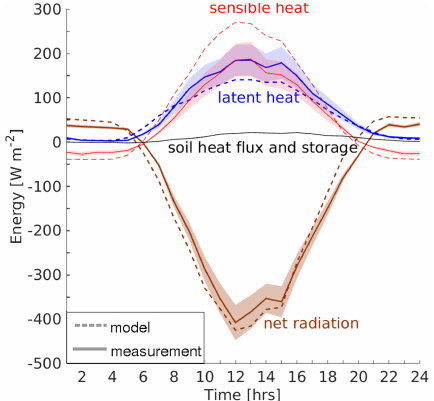
Figure 3. Diurnal averages of the components of the surface energy balance. Net radiation: sum of all radiation components in the model (the direct and diffuse global radiation, atmospheric thermal radia- tion, PAR and NIR reflected and emitted by the vegetative canopy, and the thermal radiation by the soil surface) compared to the net radiation measured for 300–40000nm above the canopy. Heat flux and storage in the soil is the average of four heat plates, and ob- served values were used as model input. Turbulent fluxes of sensible and latent heat measured with an eddy covariance system at 23.3m. The shaded areas represent the uncertainty in the measurements, which are estimated to be ± 20% for the heat fluxes and ± 10% for the net